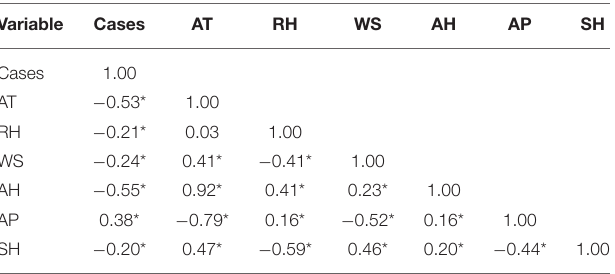
TABLE 2 | Spearman correlation between influenza case counts and meteorological parameters in Lanzhou, China during 2010–2019. Variable